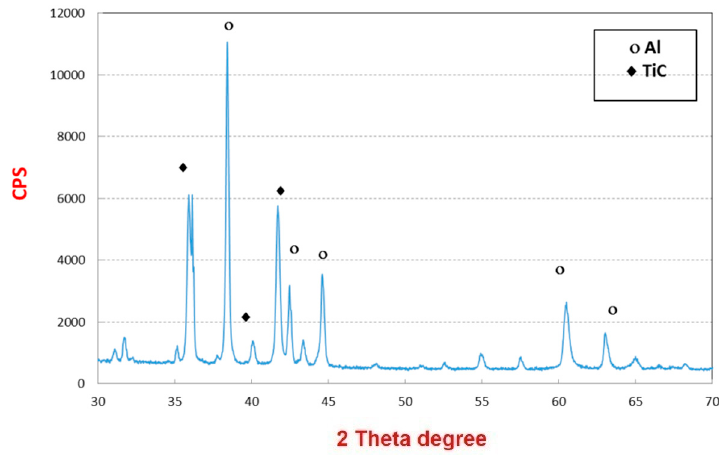
Figure 16. XRD patterns of the Al/TiC nanofibers after HFIHS.